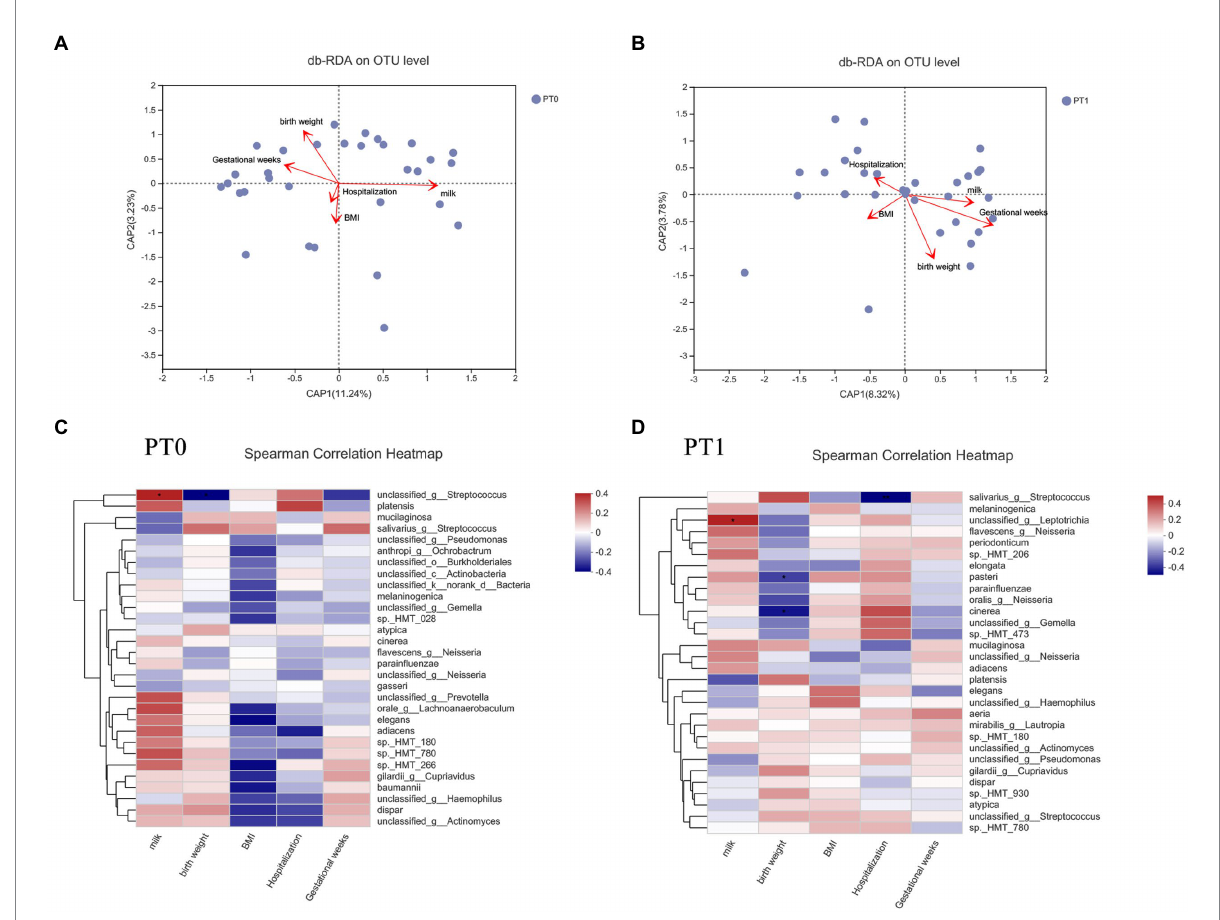
FIGURE 5 The influence factors on saliva microbiome in preterm infants. BMI, mothers’ body mass index; milk, breastfeeding durations; hospitalization, length of stay in the hospital at birth. (A,B) db-RDA plot at the OTU level in saliva samples. (C,D) Spearman’s correlation analyses for relative abundance (%) of the 30 most abundant species and associated environmental elements in saliva samples. * p < 0.05 and ** p <